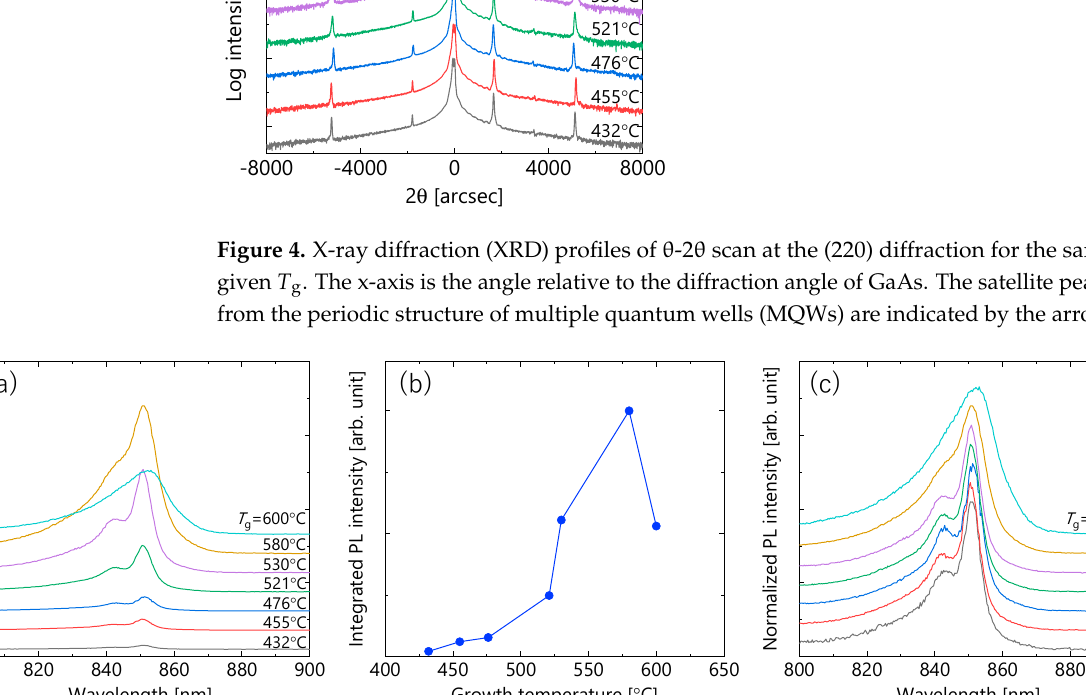
Figure 5. The data of continuous wave (CW)-PL measurements performed at RT. ( a ) PL spectra for the samples with given T g , ( b ) integrated PL intensity plotted as a function of T g , and ( c ) PL spectra normalized by the peak intensity for each spectrum depicted in ( a ).